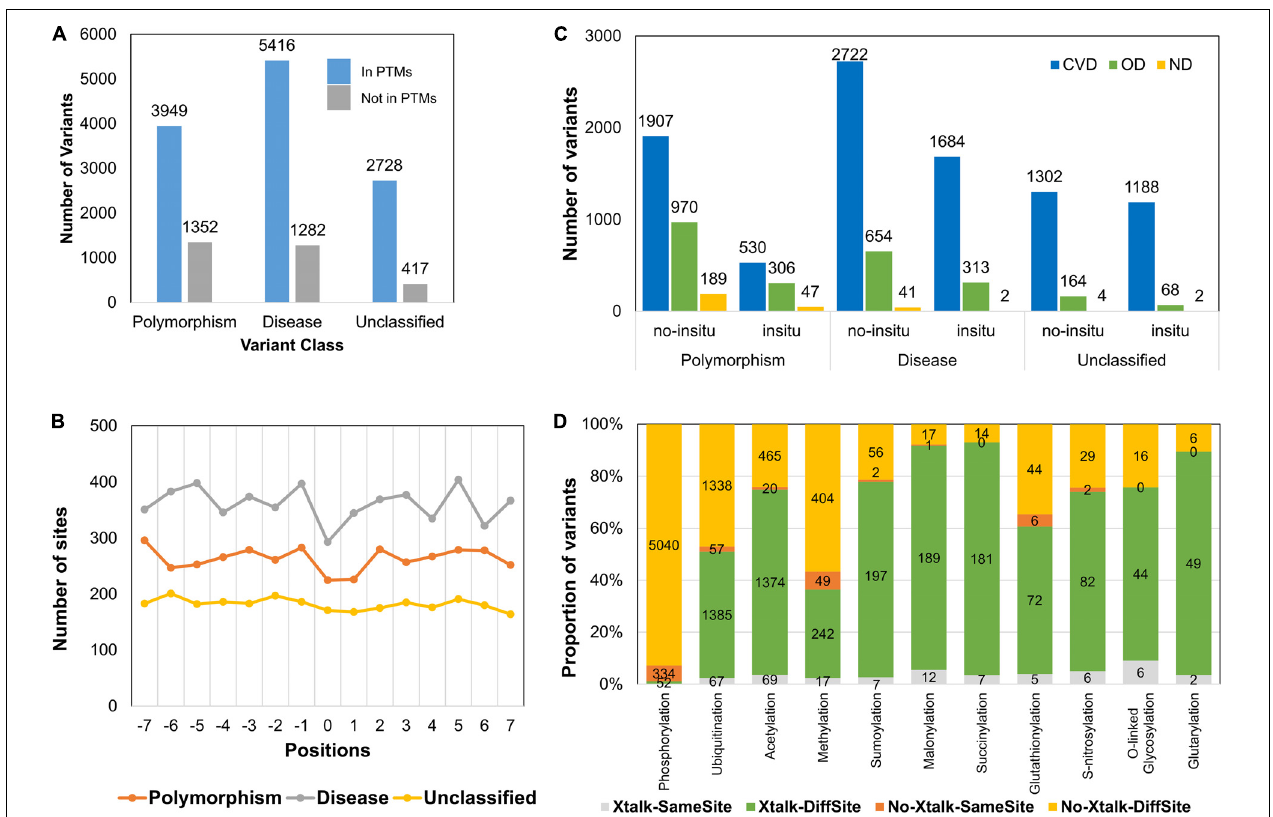
FIGURE 7 | Distribution of variants in PTM motifs. (A) Number of motif-associated variants (MAVs) in each category (polymorphic, disease-related, or unclassified). (B) Motif-associated variants as observed in disease class of proteins and their occurrence in crosstalk motifs ( in situ ). (C) Number of MAVs observed at different positions in the PTM motif. (D) Proportion of MAVs in crosstalk/PTM motifs for each PTM